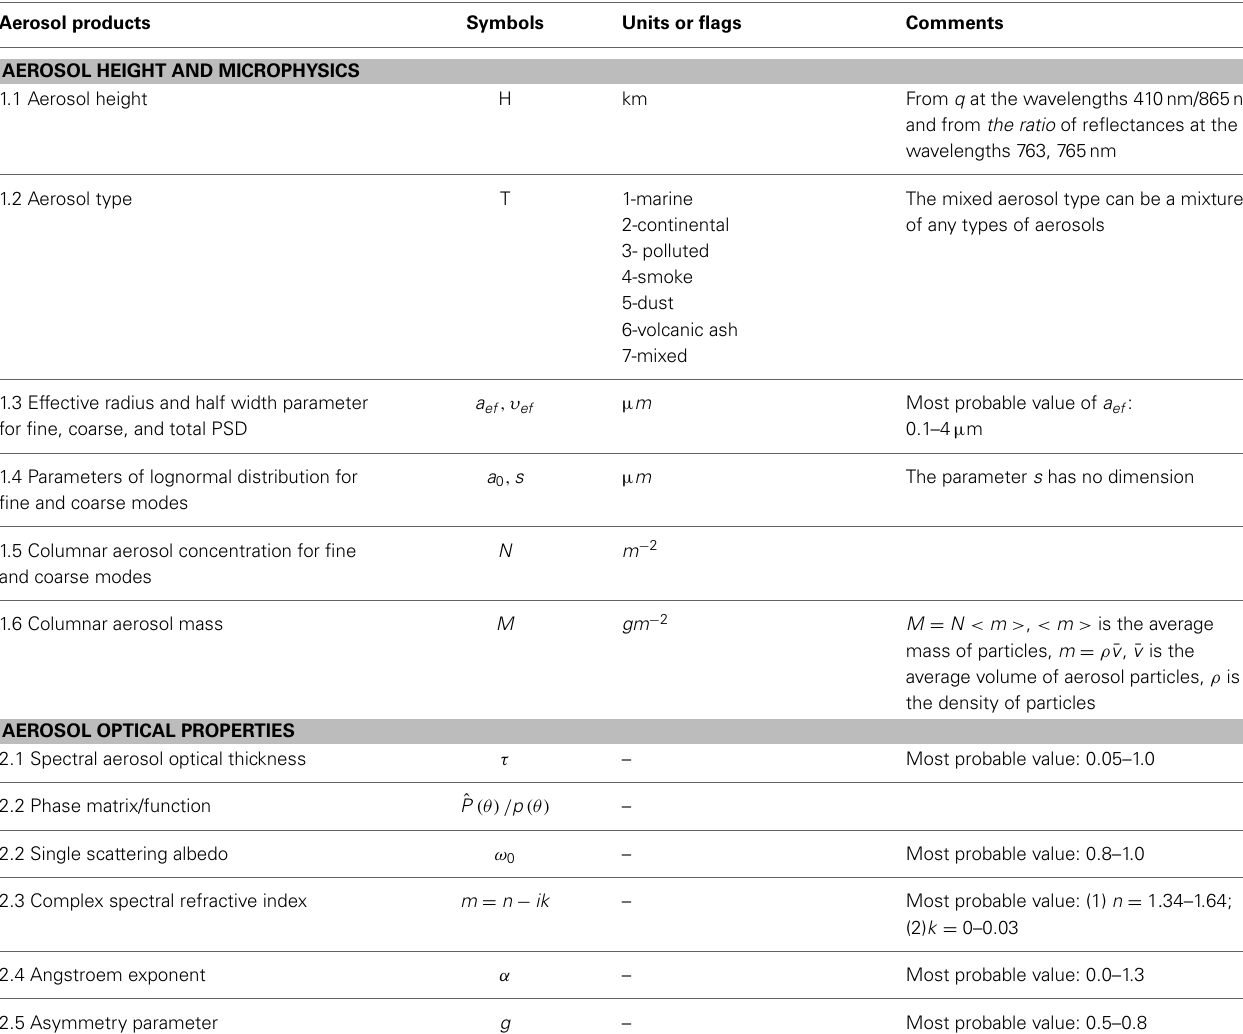
Table 3 | The aerosol